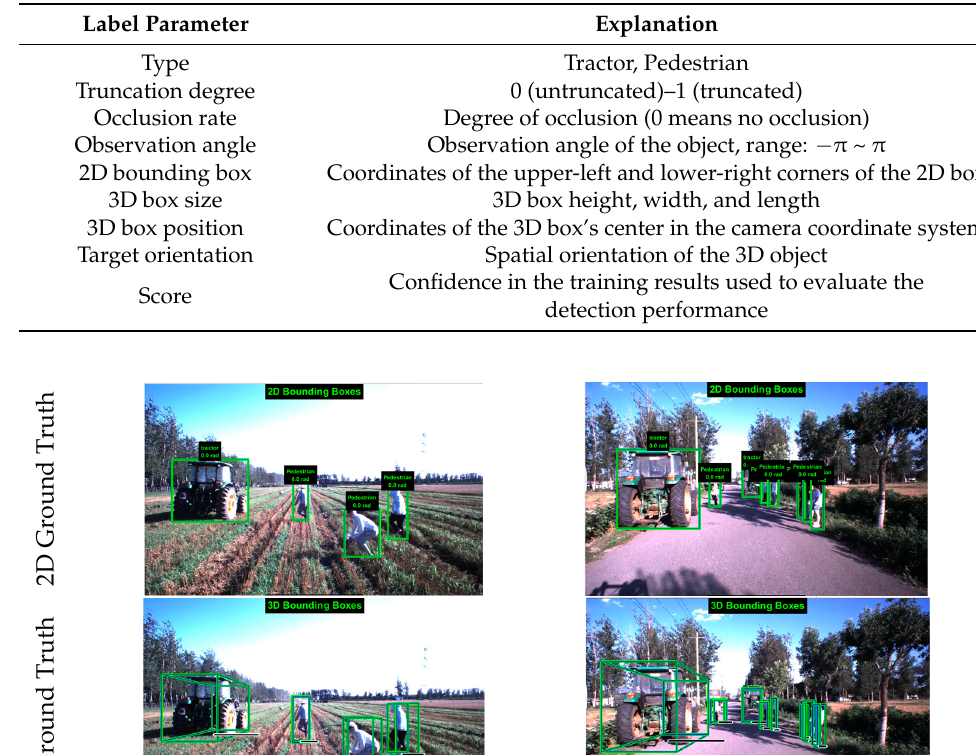
Table 1. Dataset label format.